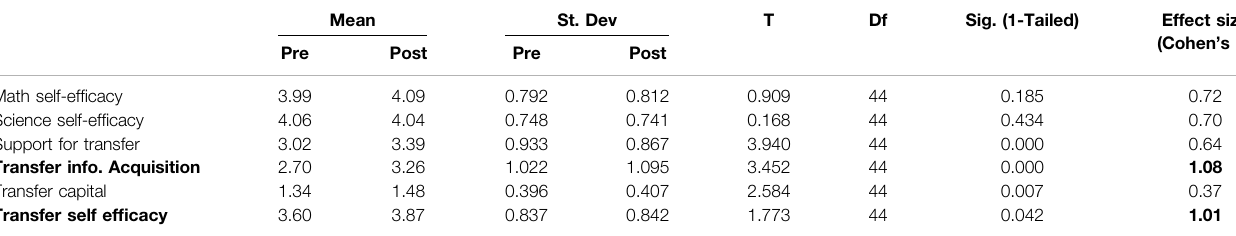
TABLE 4 | Summary of paired T -Tests for transfer readiness analysis.